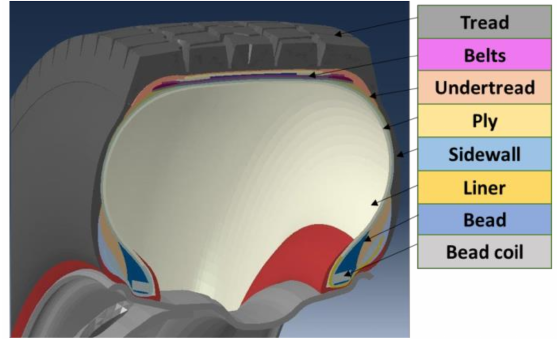
Figure 2. Typical internal structure of a truck